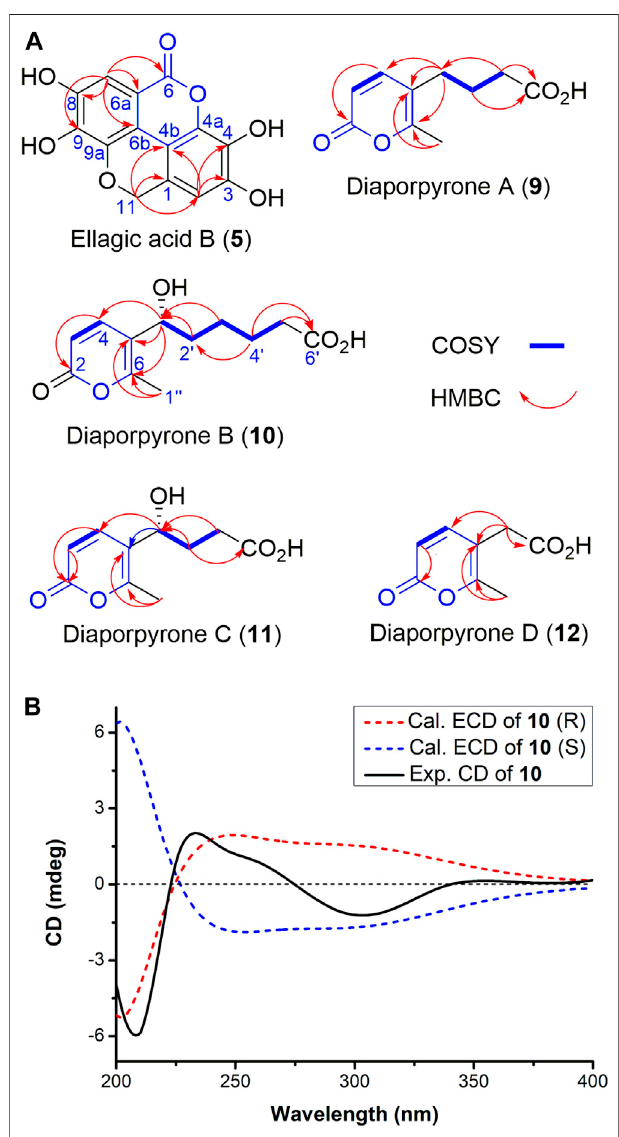
FIGURE 2 | (A) Key 1 H – 1 H COSY and HMBC correlations of compounds 5 and 9 – 12 . (B) ExperimentalandcalculatedECDspectraofcompounds 10 inMeOH.